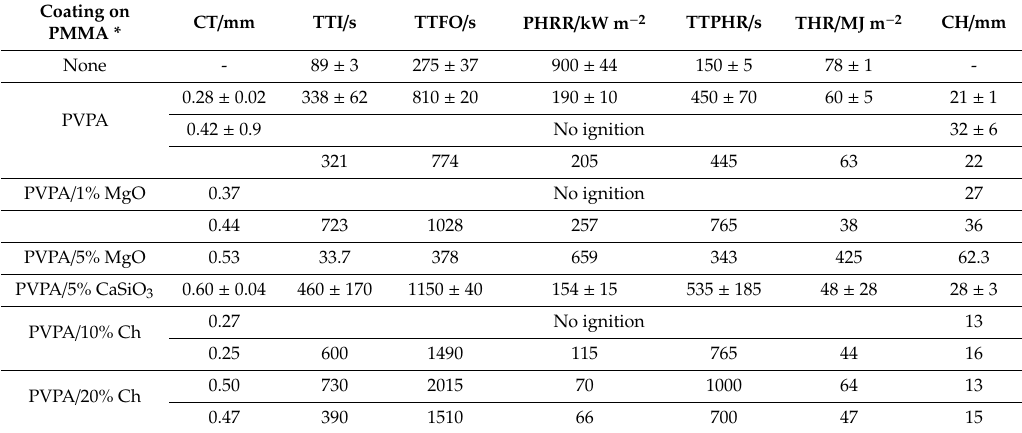
CT = coating thickness, TTI = time to ignition, TTFO = time to flame out, PHRR = peak heat release rate, TTPHR = time to peak heat release, THR = total heat released, CH = char height. * 75 mm × 75 mm plaque of PMMA.